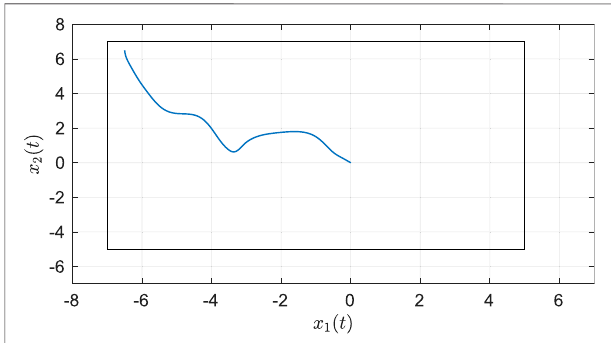
FIGURE 2 | Phase portrait for the two-state dynamical system using MBRL with FCL in the original coordinates. The boxed area represents the user-selected safe set.